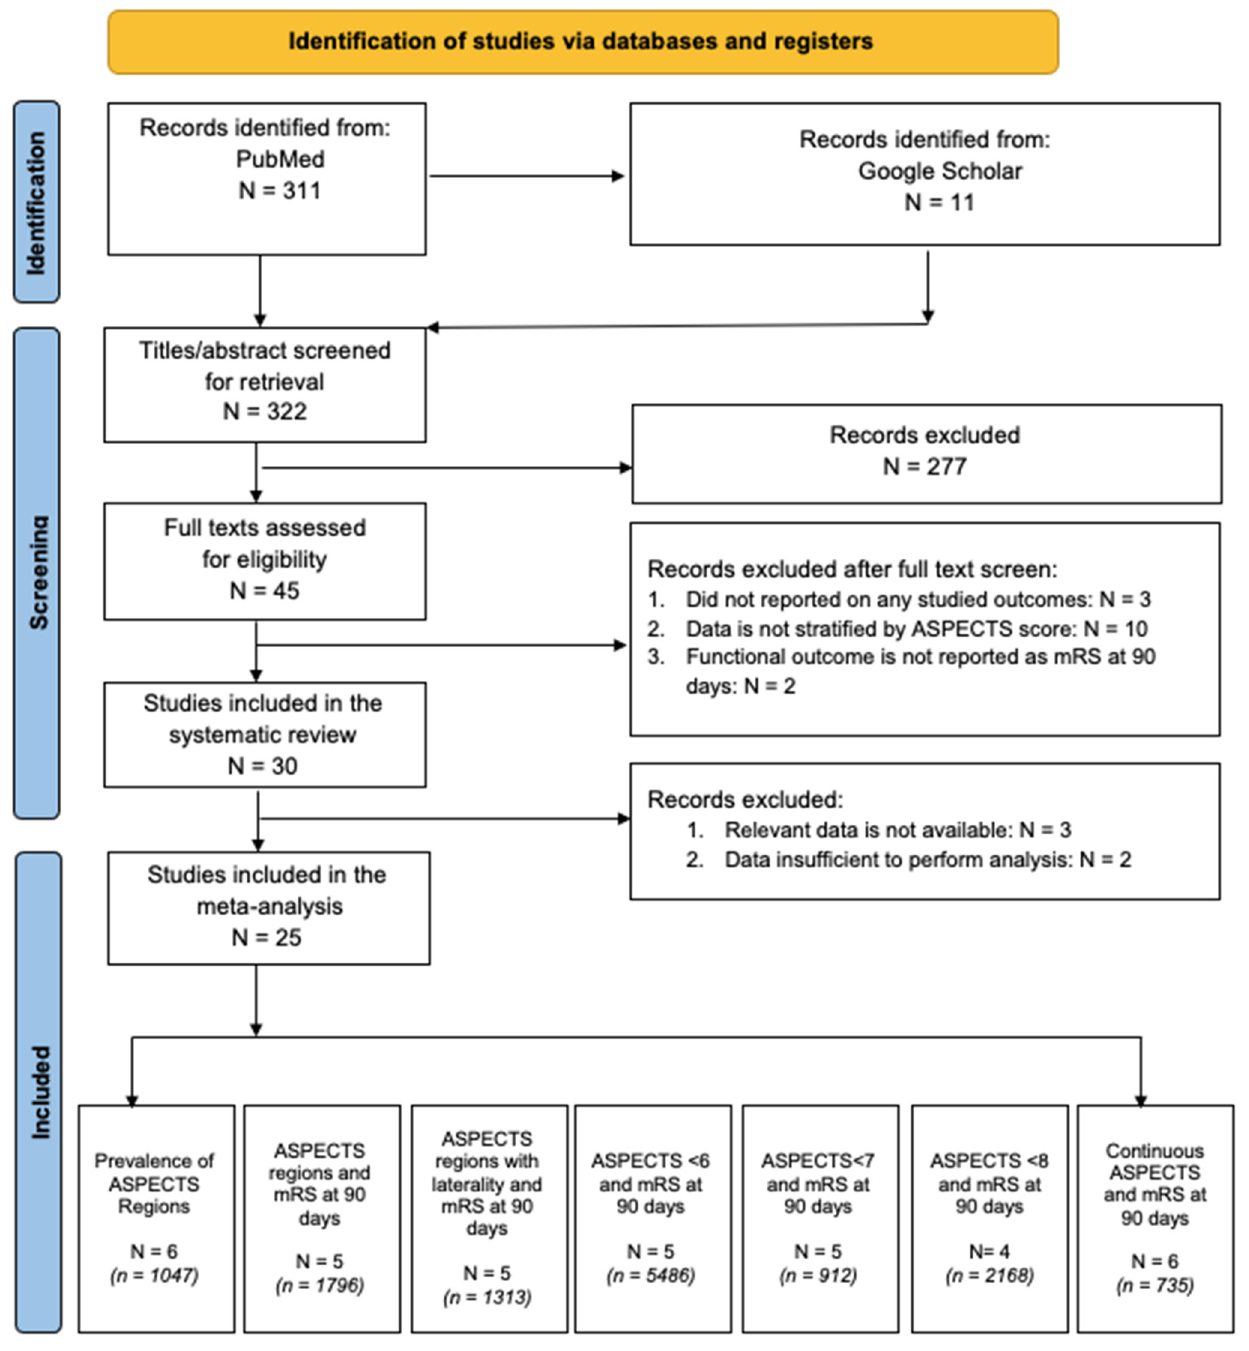
Figure 1. The PRISMA flowchart showing the studies included in the meta-analysis. Abbreviations: N = number of studies; n = number of patients; mRS: modified Rankin Score; ASPECTS: Alberta Stroke Programme Early CT Score.